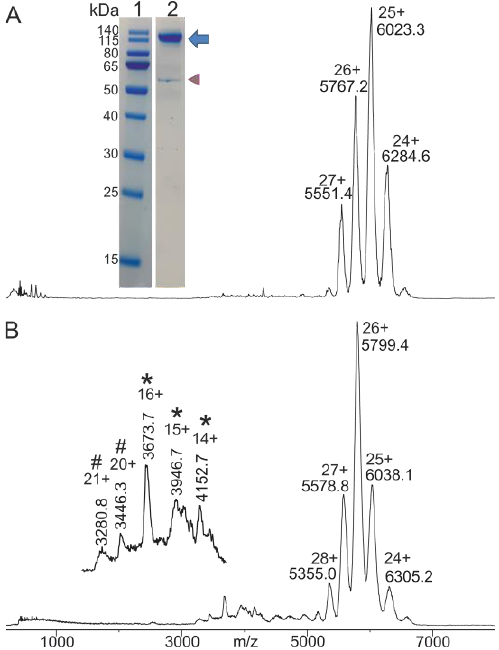
Figure 1. Characterization of an IgG mix prepared from blood serum. ( A ) Nano-ESI mass spectrum of IgG mix (solution 0). Charge states and m / z values are provided for the multiply charged IgG ion signals. Quadrupole vacuum: 3.9 × 10 − 5 mbar. Insert: SDS-PAGE analysis of IgG mix prepared from serum under non-reducing conditions. Lane 1: molecular mass marker (PageRuler Prestained Protein Ladder). Apparent molecular masses are shown at the left. Lane 2: from blood-serum-isolated IgG mix (1 µ g protein). Proteins were stained with colloidal Coomassie Brilliant Blue. The blue arrow points to the IgG band. The purple arrow head indicates residual serum albumin. ( B ) Nano-ESI mass spectrum of IgG mix (solution 0). Charge states and m / z values are provided for the multiply charged IgG ion signals. Quadrupole vacuum: 3.2 × 10 − 5 mbar. Insert: ion signals ( m / z values and charge states) of residual monomeric serum albumin (#) and tetrameric transthyretin (*). Protein concentration is 0.34 µ g/ µ L. 2.5 µ L were loaded. Solvent: 200 mM ammonium acetate, pH 6.7. Recording time per spectrum is 1